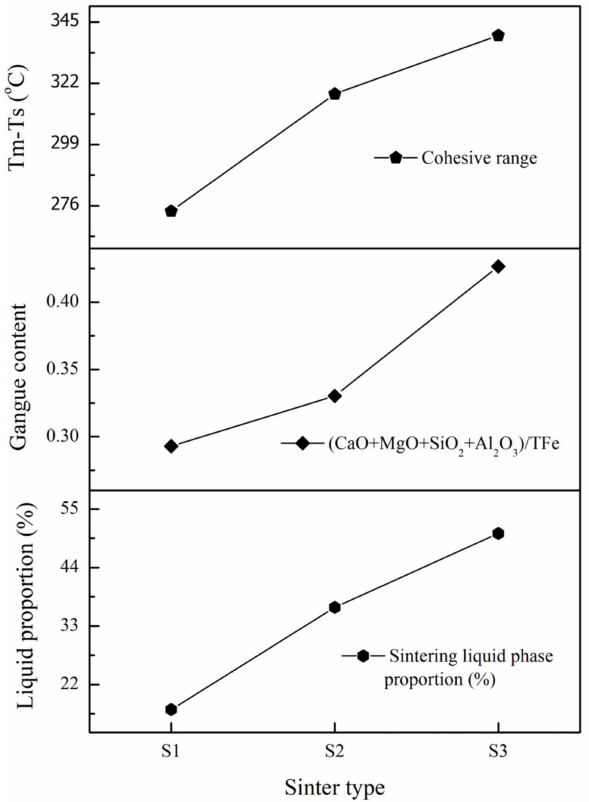
Figure 8. Correlation of sintering liquid proportion and sinters gangue content with the sinters cohesive